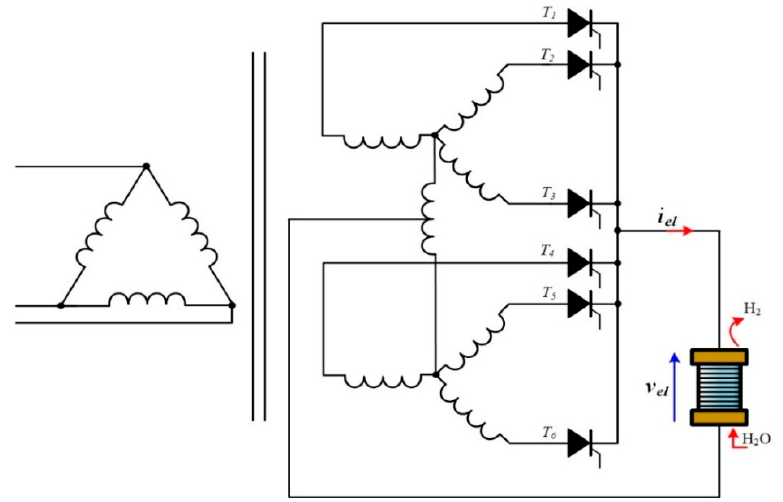
Figure 10. Six-pulse thyristor double-star rectifier.